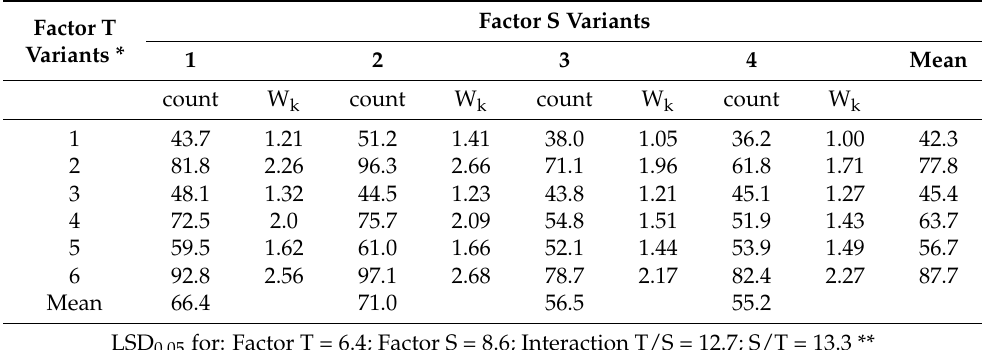
Table 5. The total number of the soil microorganisms, depending on the tillage method (factor T) and stubble management (factor S) applied in the spring wheat cultivation [10 6 cfu g − 1 ].